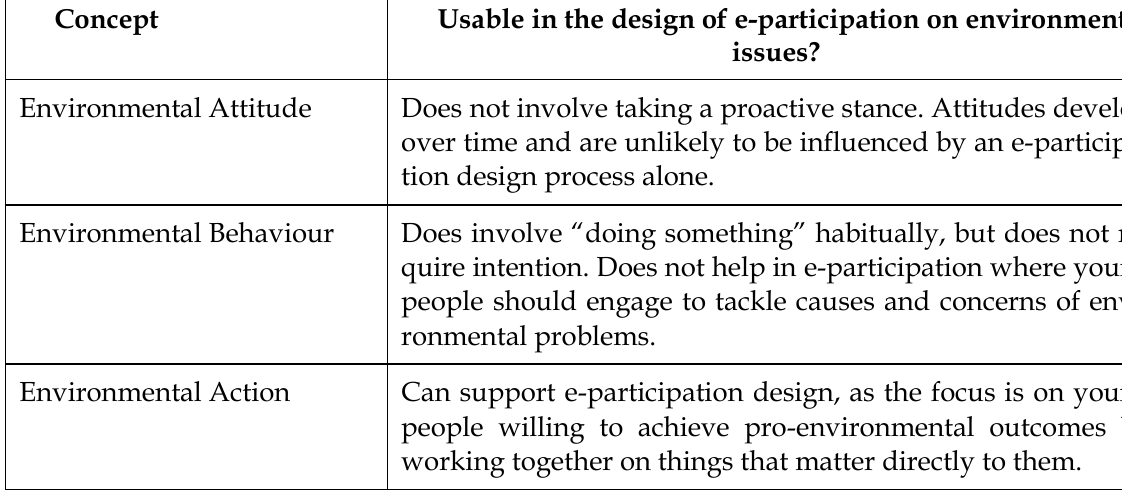
Table 1: Concepts and their potential connection with environmental e-participation design